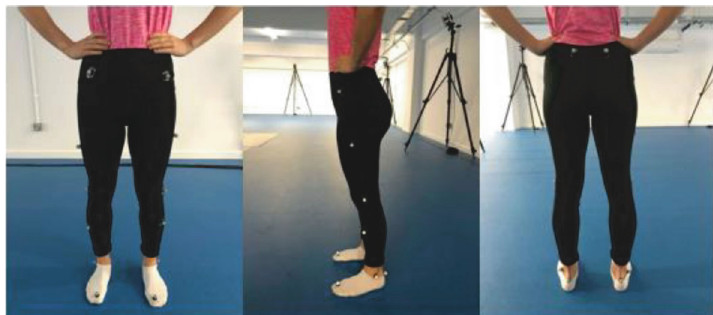
Figure 1: Visual representation of marker placement — positioning of sixteen retrore fl ective markers on the lower limbs of a participant.